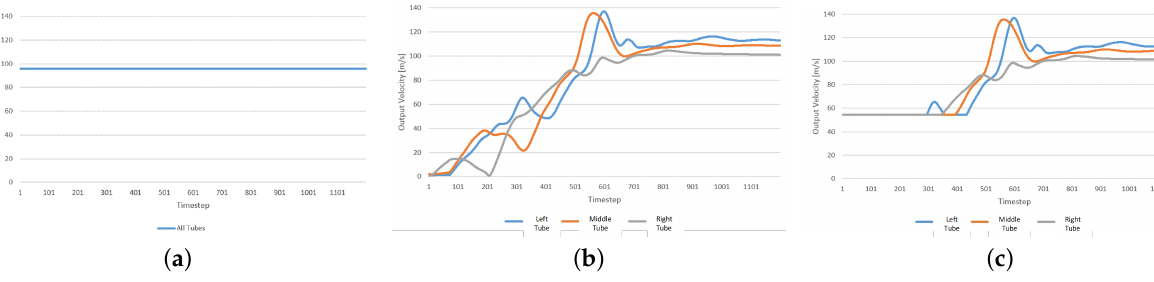
Figure 8. Flow velocity output value for the three-finger condition. (a) Constant . (b) FlowEst1 . (c) FlowEst2